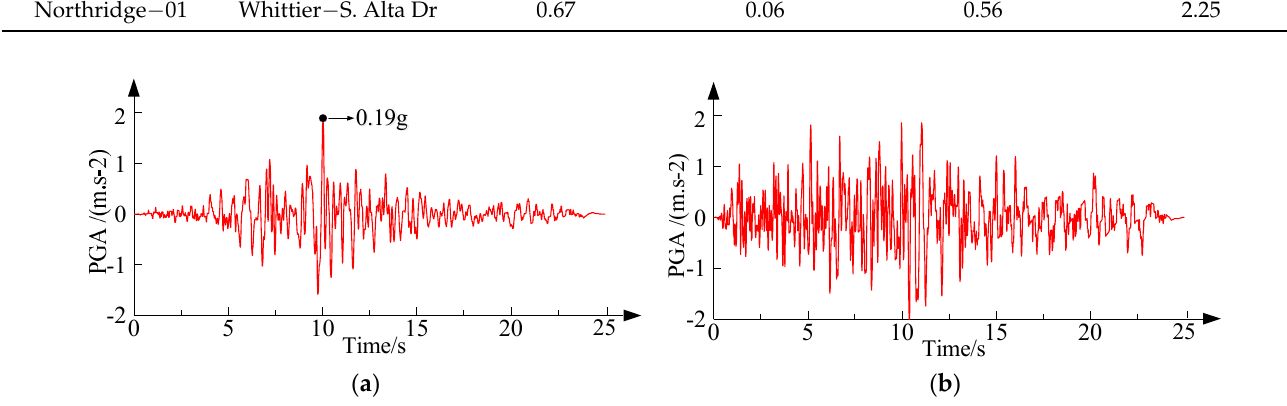
Figure 3. Time history records of seismic accelerations. ( a ) Transverse; ( b ) Vertical. Table 3. Ground motion parameters of natural wave Northridge-01.